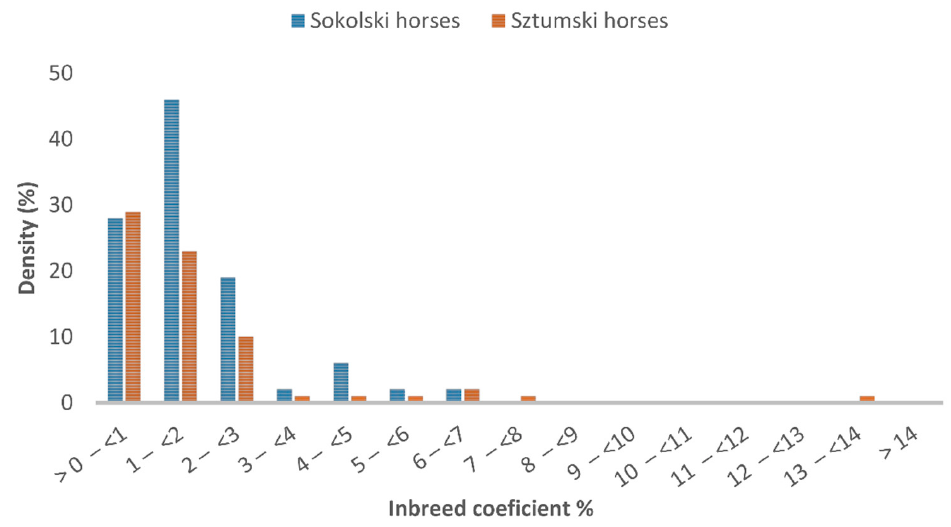
Figure 2. Inbreeding coefficient in 175 analyzed Sztumski and Sokólski cold ‐ blooded horses, based on pedigree information.